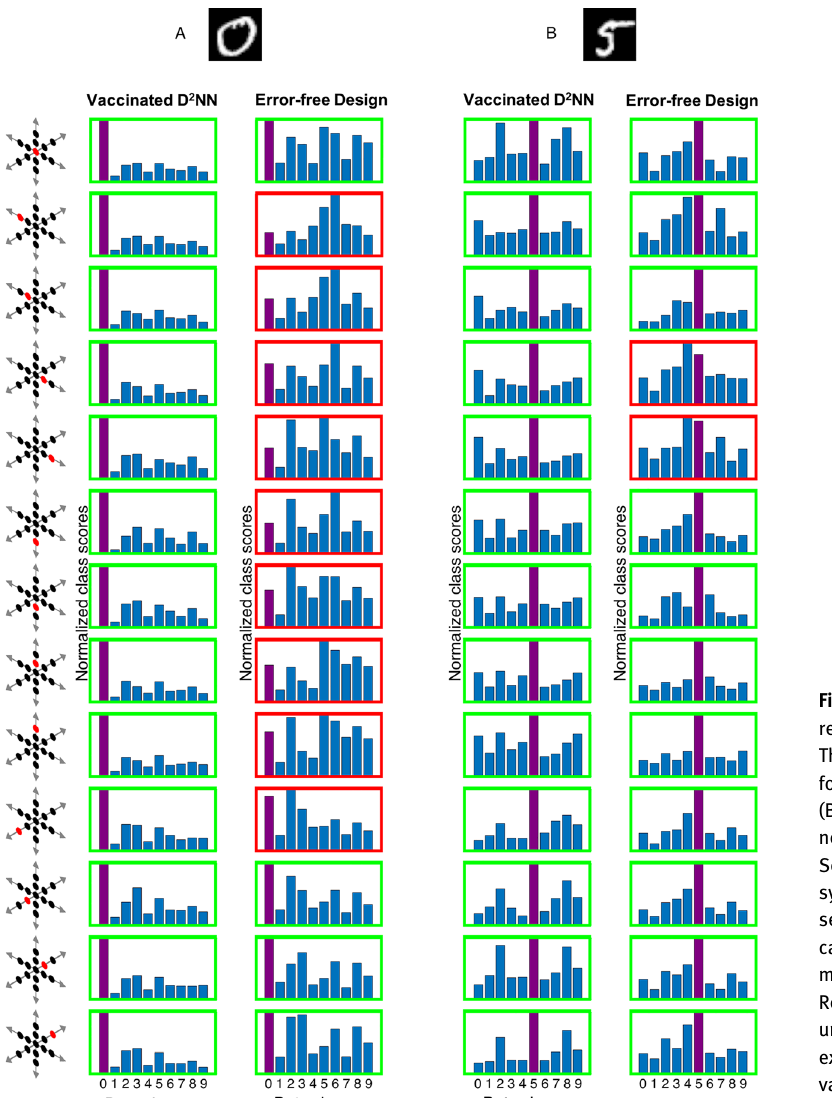
Figure 6: Experimental image classification results as a function of misalignments. (A) The experimentally measured class scores forhandwrittendigit ‘ 0 ’